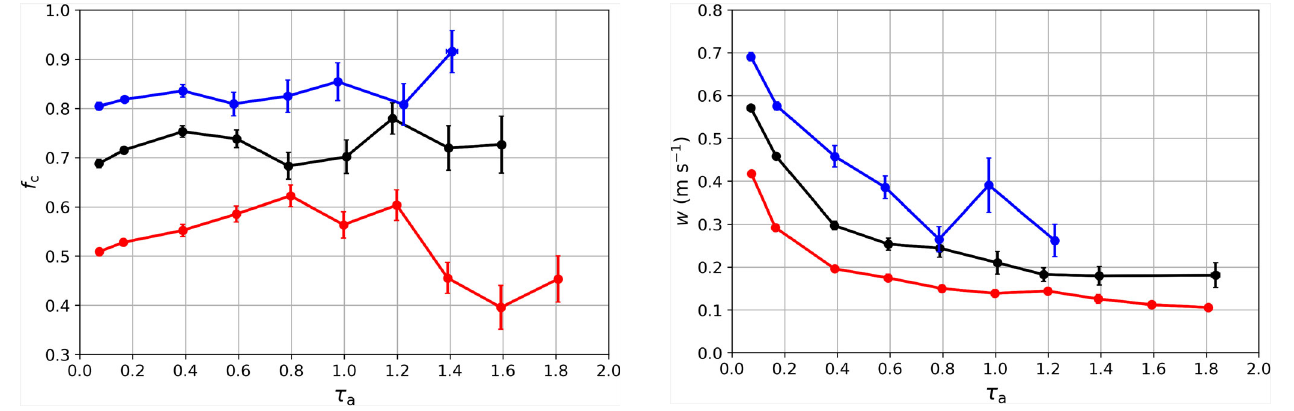
Fig. 2 Cloud fraction ( f c ) for convective clouds, from 2000 to 2014, as a function of the columnar aerosol optical depth ( τ a ), according to classes of atmospheric preconditioning. Red, black, and blue coloring, error bars and τ a as in Fig. 1. Cloud fraction was inferred from GOES satellite imagery acquired in 100 x 100 km boxes around the AERONET sites between 17:00 and 18:00 UTC (13:00 – 14:00 LT).